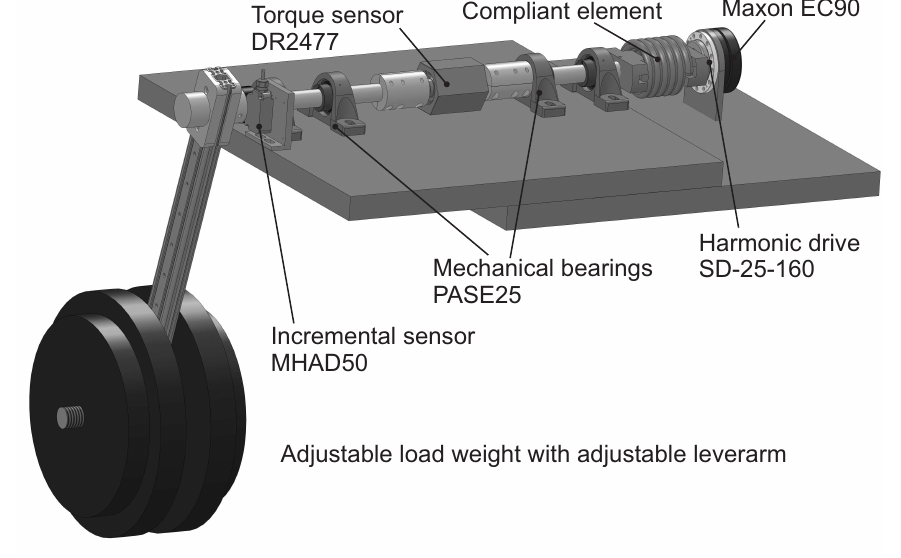
Test bench with exchangeable compliant element and adjustable load (mass and lever arm).